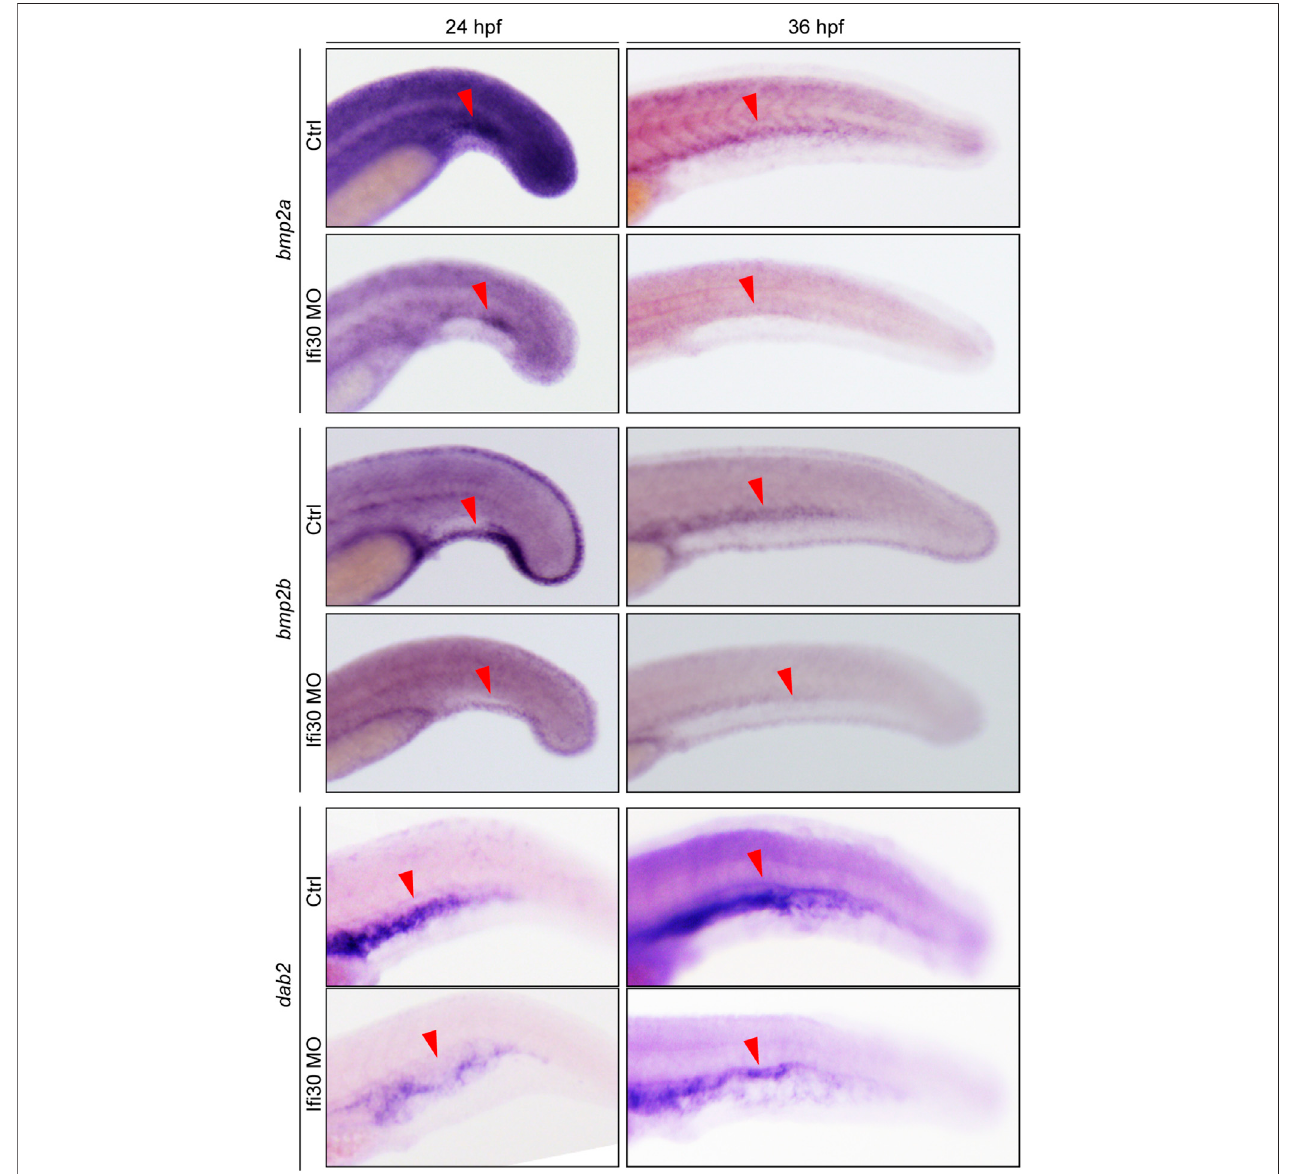
FIGURE 5 | I fi 30 knockdown disrupts Bmp2 signaling pathway. In situ hybridization for bmp2b , bmpr2a , and dab2 of control embryos and embryos injected with I fi 30 MO at 24 and 36 hpf.